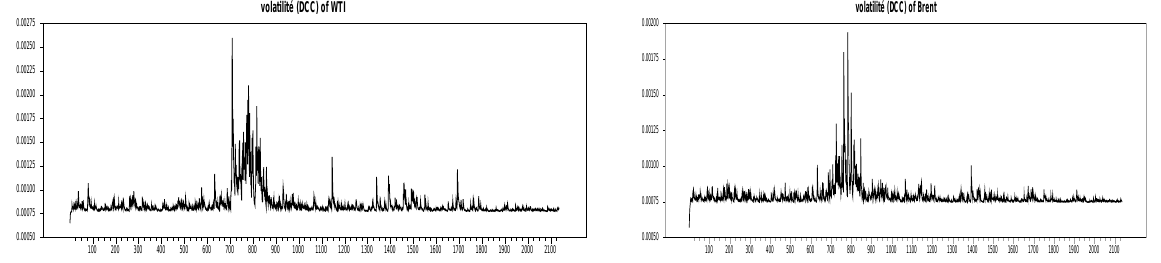
Fig. 2. Oil price volatility